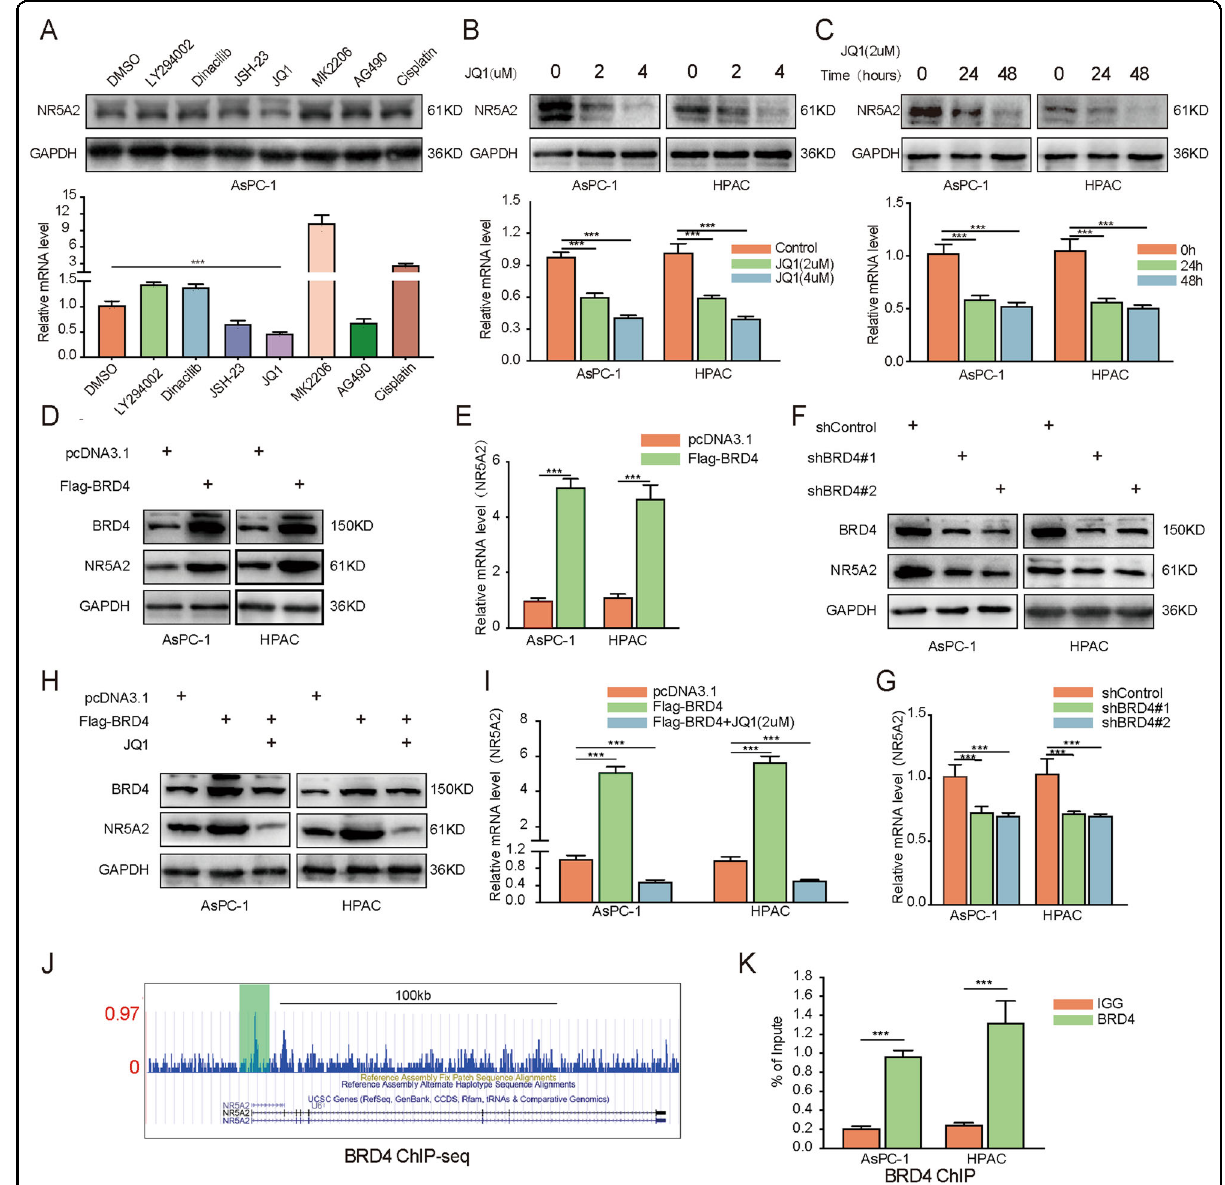
Fig. 4 BRD4 transcriptionally activates NR5A2 expression in pancreatic cancer cells. A Western blot analysis and RT-qPCR assay to show the NR5A2 expression in AsPC-1 cells treated with different inhibitors. GAPDH served as an internal reference. Data presented as the mean ± SD of three independent experiments. *** p < 0.001, one-way ANOVA. B AsPC-1 and HPAC cells treated with JQ-1 for different concentrations were harvested for Western blots and RT-qPCR analysis. GAPDH served as an internal reference. Data presented as the mean ± SD of three independent experiments. *** p < 0.001, one-way ANOVA. C AsPC-1 and HPAC cells treated with JQ-1 for different durations were harvested for Western blots and RT-qPCR analysis. GAPDH served as an internal reference. Data presented as the mean ± SD of three independent experiments. *** p < 0.001, one-way ANOVA. D , E AsPC-1 and HPAC cells infected with pcDNA3.1 or BRD4 plasmid were harvested for Western blots ( D ) and RT-qPCR analysis ( E ). GAPDH served as an internal reference. All the data are mean ± S.D. from experiments with three replicates. *** p < 0.001. Statistical analyses were performed using unpaired t test. F , G AsPC-1 and HPAC cells infected with shControl or shNR5A2s were harvested for Western blots ( F ) and RT-qPCR analysis ( G ). GAPDH served as an internal reference. All the data are mean ± S.D. from experiments with three replicates. *** p < 0.001, one-way ANOVA. H , I AsPC-1 and HPAC cells infected with pcDNA3.1 or BRD4 plasmid and treated with or without JQ-1 were harvested for Western blots ( H ) and RT-qPCR analysis ( I ). GAPDH served as an internal reference. All the data are mean ± S.D. from experiments with three replicates. *** p < 0.001, one-way ANOVA. J A UCSC Genome Browser was used to show BRD4 ChIP-seq signal pro fi les in the NR5A2 gene locus 13 . K ChIP-qPCR of BRD4 in AsPC-1 and HPAC cells. All data are shown as the mean values ± SD from three replicates. *** p < 0.001, unpaired t